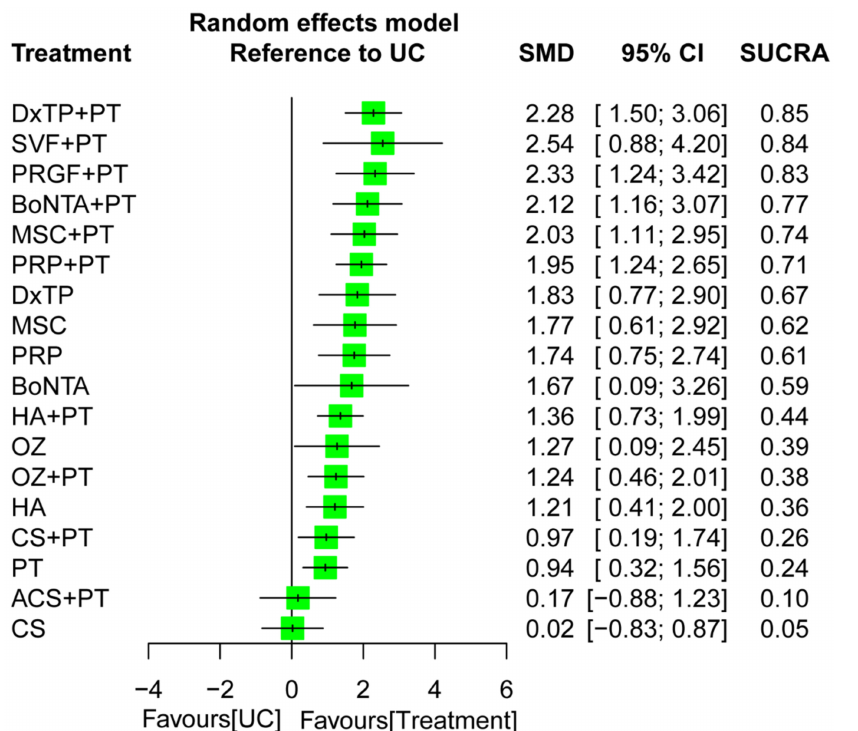
Figure 4. Forest plot summarizing the effects of treatment regimens on global function restoration for the entire follow-up duration. SMD, standardized mean difference; CI, confidence interval; SUCRA, surface under the cumulative ranking curve; ACS, autologous conditioned serum; BoNTA, botulinum toxin type A; CS, corticosteroid; DxTP, dextrose prolotherapy; HA, hyaluronic acid; MSC, mesenchymal stem cell; OZ, ozone; PRP, platelet-rich plasma; PRGF, plasma rich in growth factor; PT, physical therapy; SVF, stromal vascular fraction; UC, usual